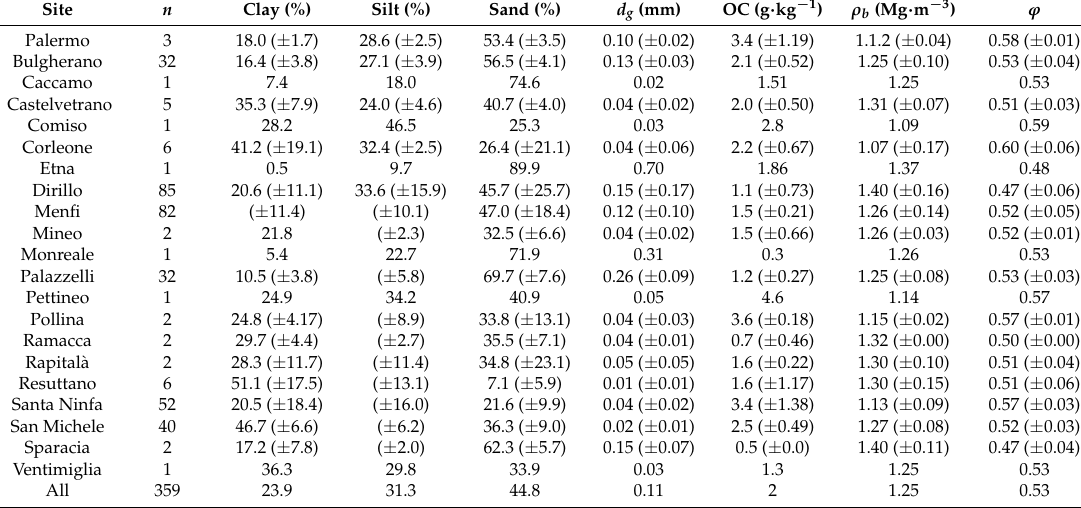
Table 1. Mean values and standard deviations of the fractions of clay (Cl), silt (Si), and sand (Sa), geometric mean particle diameter ( d g ), dry soil bulk density ( ρ b ), organic carbon content (OC), and porosity ( ϕ ) for the investigated Sicilian soils; n is the number of sampled soils at each site.